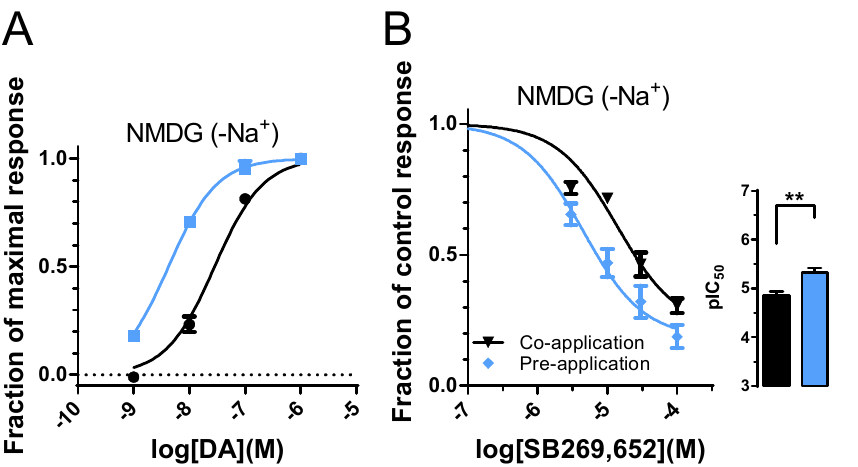
Figure 4. Concentration–response relationship of SB269,652 at the D 2 R under nominally sodium-free conditions. ( A ) Concentration–response relationships for DA at the WT D 2 R under control conditions (black, same as shown in Figure 1B, n = 8), and under sodium-free conditions (blue, n = 3). See Table 1 for pEC 50 values. ( B ) Concentration–response relationships for SB269,652 at the D 2 R, co-applied with 10 nM DA (black, n = 5–8) and pre-applied during 87 s (blue, n = 5). See Table 2 for pIC 50 values. Data are displayed as mean ± SEM. Asterisks indicate statistical significance: **, p < 0.01, F-test.